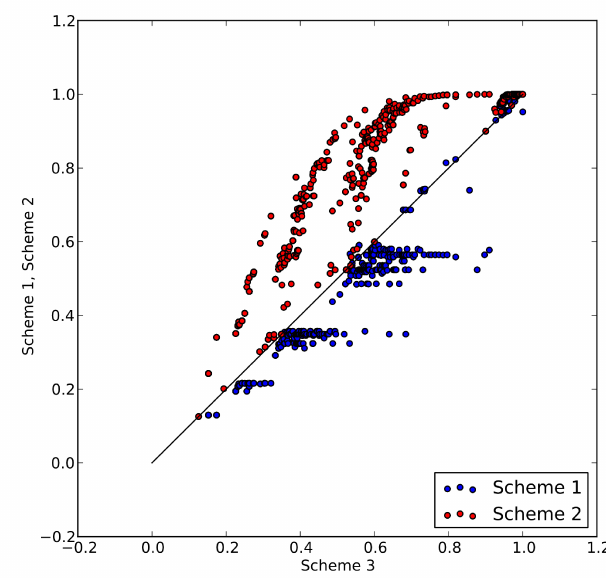
Figure 2. Scatter plot: scheme #3 vs schemes #1 and